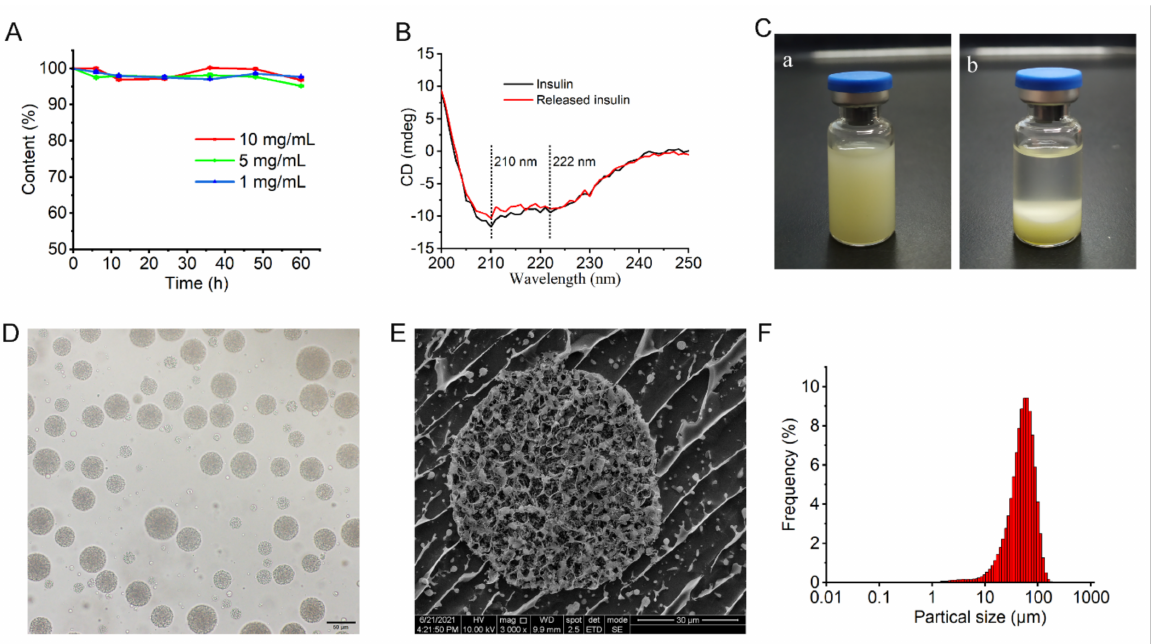
Figure 4. Characterization of MVL(F+E+I): ( A ) Stability of insulin solutions at different concentrations. Data are shown as mean ± SD ( n = 3). ( B ) CD spectra of insulin and insulin released from MVLs. ( C ) Appearance of MVL(F+E+I) suspension ( a ); appearance of MVL(F+E+I) suspension after standing for 1 d at 4 ◦ C ( b ). ( D ) Photomicrograph of MVL(F+E+I). Scale bar = 50 µ m. ( E ) Cross-sectional view of MVL(F+E+I) observed by cryo-SEM. Scale bar = 30 µ m. ( F ) Size distribution of MVL(F+E+I) determined using a laser particle size